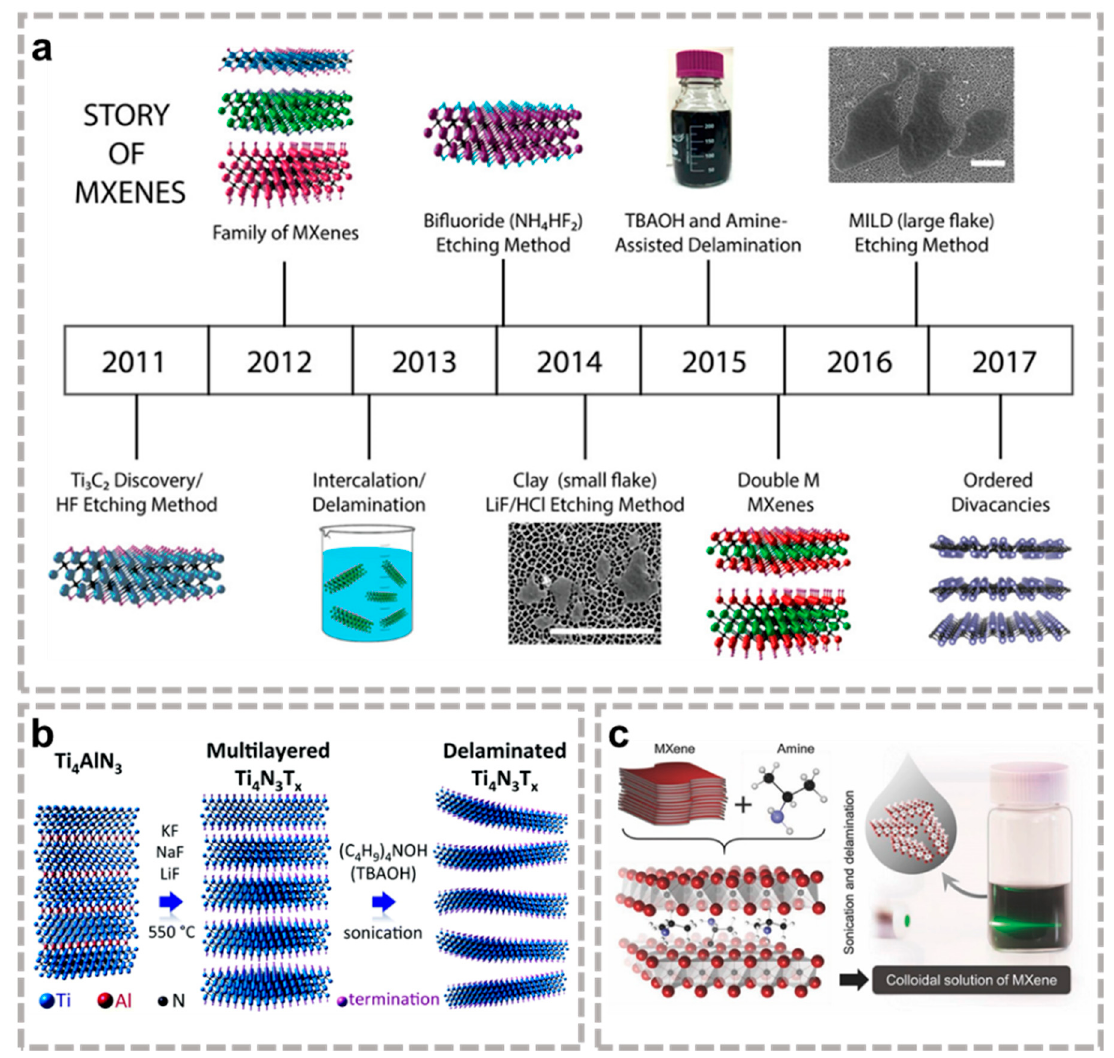
Figure 2. ( a ) The history of MXene synthesis [41]. ( a ) Reproduced with permission from the American Chemical Society. ( b ) Schematic diagram of molten fluorine salt etching Ti 4 N 3 T x [34]. ( b ) Reproduced with permission from RSC Pub. ( c ) Nb 2 CT x MXene delamination process [38]. ( c ) Reproduced with permission from WILEY-VCH.